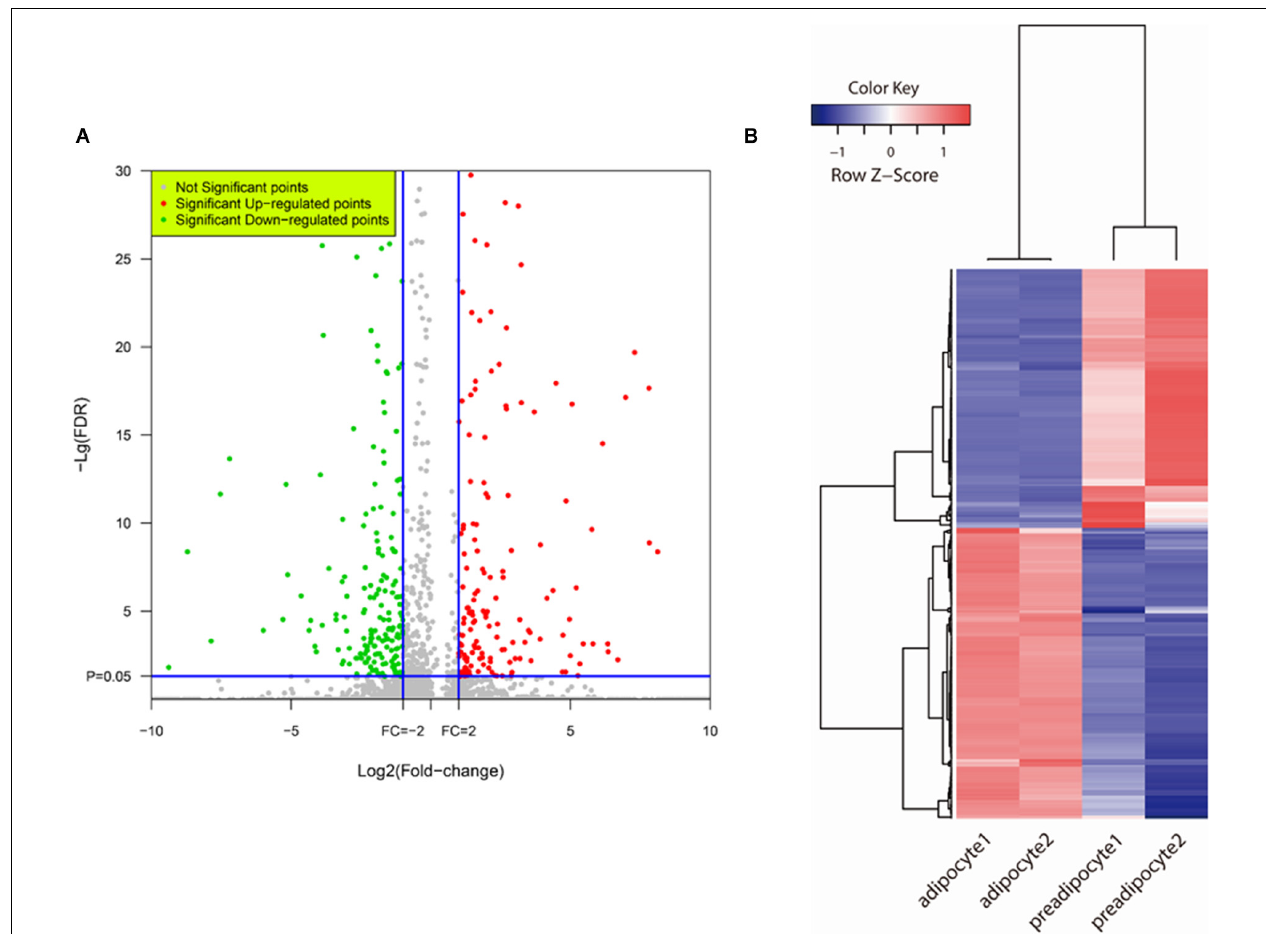
FIGURE 3 | DEGs detection. (A) Volcano plot of bovine adipogenesis related DEGs expression profiling. Red plots represent genes up-regulated significantly and green plots represent genes down-regulated significantly. (B) Heat map of DEGs. Hierarchical cluster and cluster tree analysis was used to create the dendrogram. The heat map compares fold change patterns of the most highly DEGs in preadipocytes and adipocytes. Each line represents one gene. Left two panels: adipocyte; Right two panels: preadipocytes. Red indicates high expression; blue indicates low